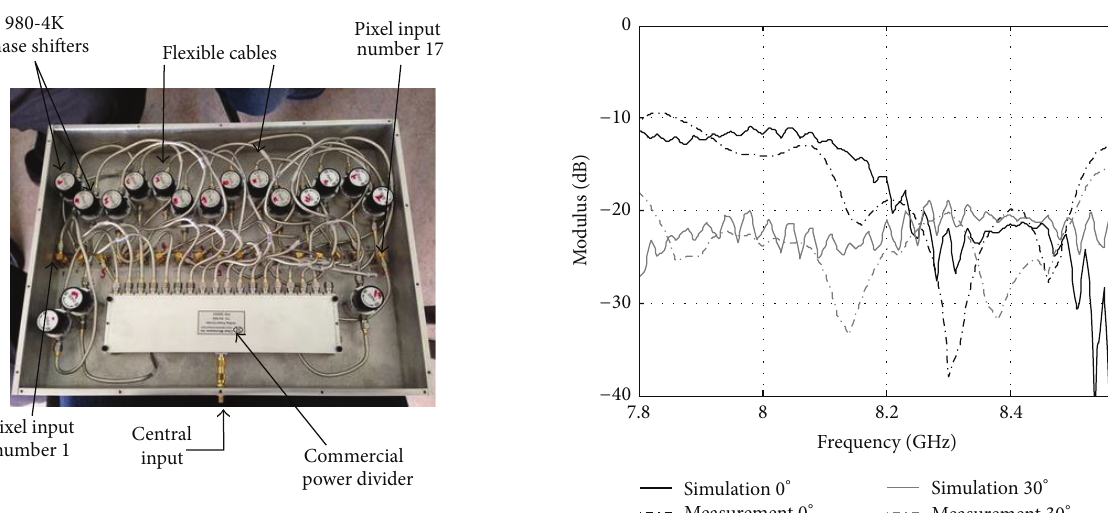
Figure 7: Beam forming network placed at the metallic support’s bottom leading to obtain a Gaussian radiation beam. Figure 8: Simulated and measured matching coefficients of the global system for the first configuration: (a) broadside direction and (b) 30 ∘ pointing